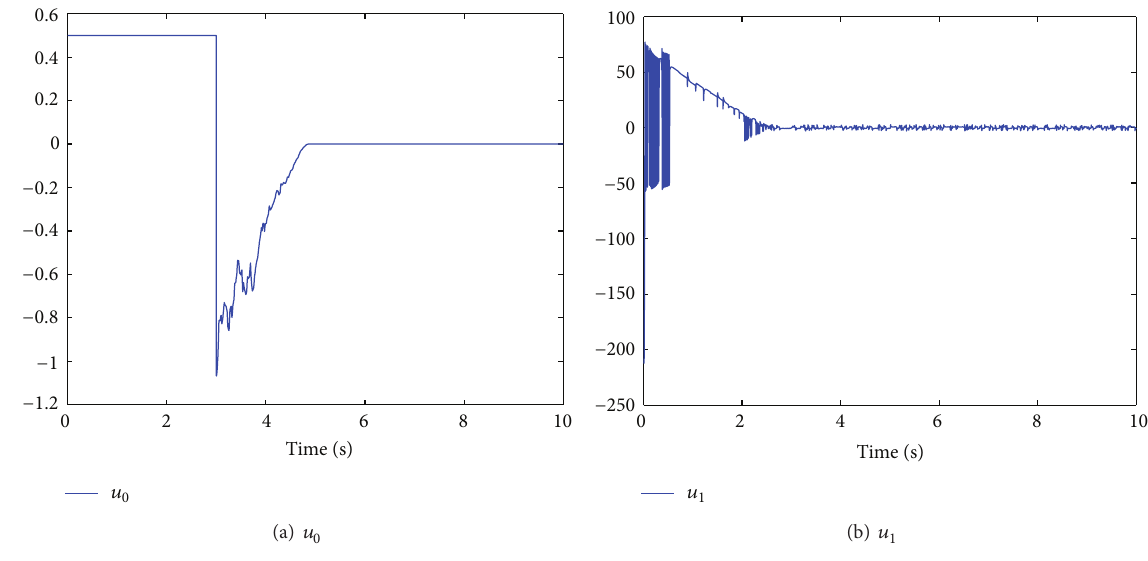
Figure 2: Control inputs of the closed-loop